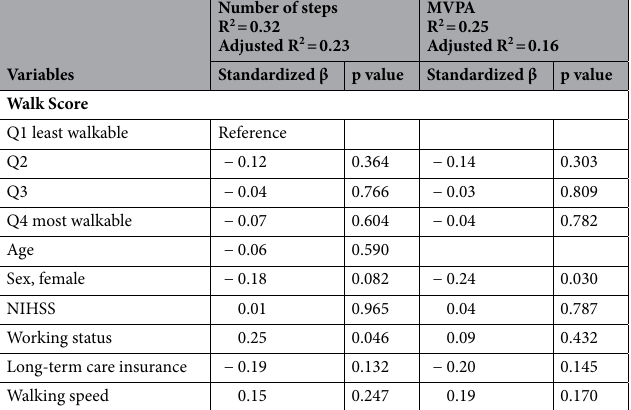
Table 2. Associations between objectively measured physical activity and walkability by multiple linear regression analysis. MVPA moderate-to-vigorous physical activity, NIHSS National Institutes of Health Stroke Scale, R 2 coefficient of determination, β regression